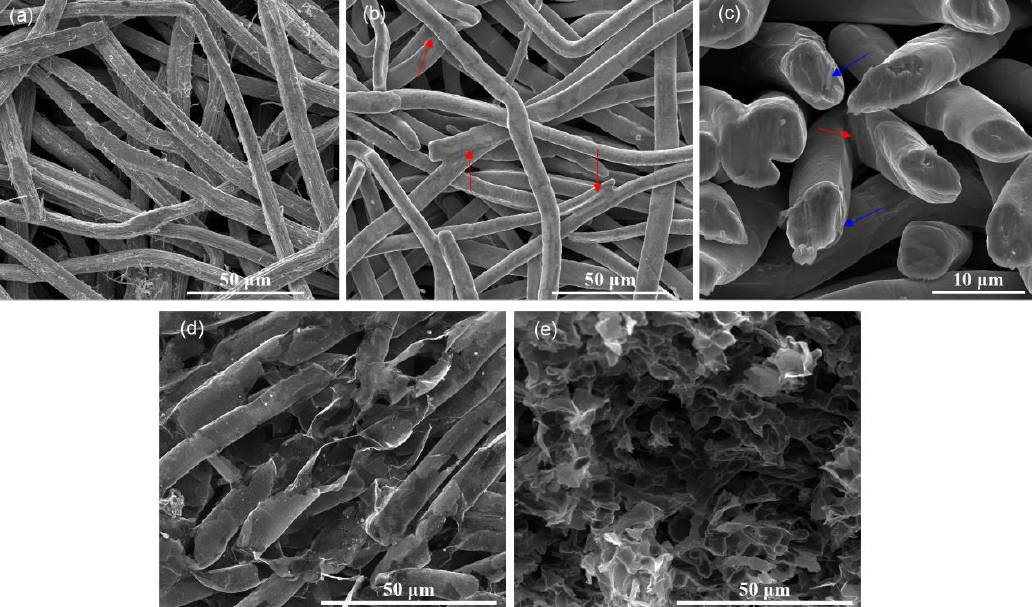
Figure 2. Top view scanning electron microscope (SEM) images of nickel network before ( a ) and after chemical vapor deposition (CVD) process ( b ); cross-section view of nickel network after CVD process ( c ); top view ( d ) and cross-section view ( e ) of GN after nickel was etched away. Red arrows in (b) and (c) indicate the nodes where nickel fibers were sintered and aggregated, blue arrows in (c) indicate the positions where graphene was peeled off.